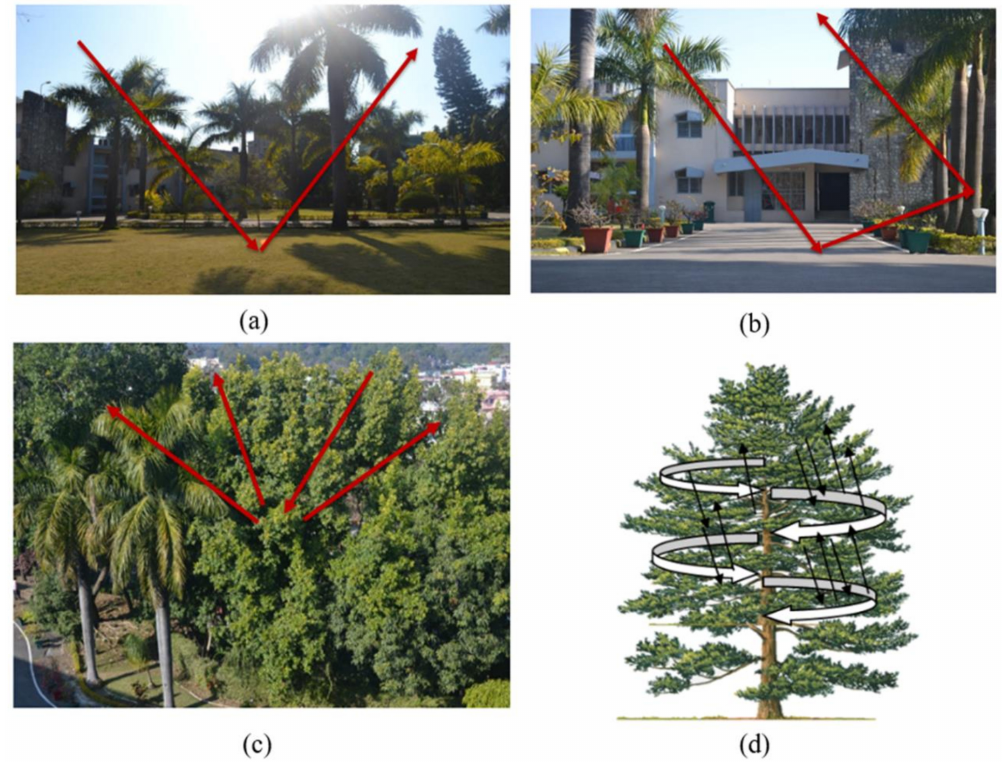
Figure 5. Four component decomposition of scattering powers: ( a ) surface scattering, ( b ) double-bounce scattering, ( c ) volume scattering, and ( d ) helix scattering